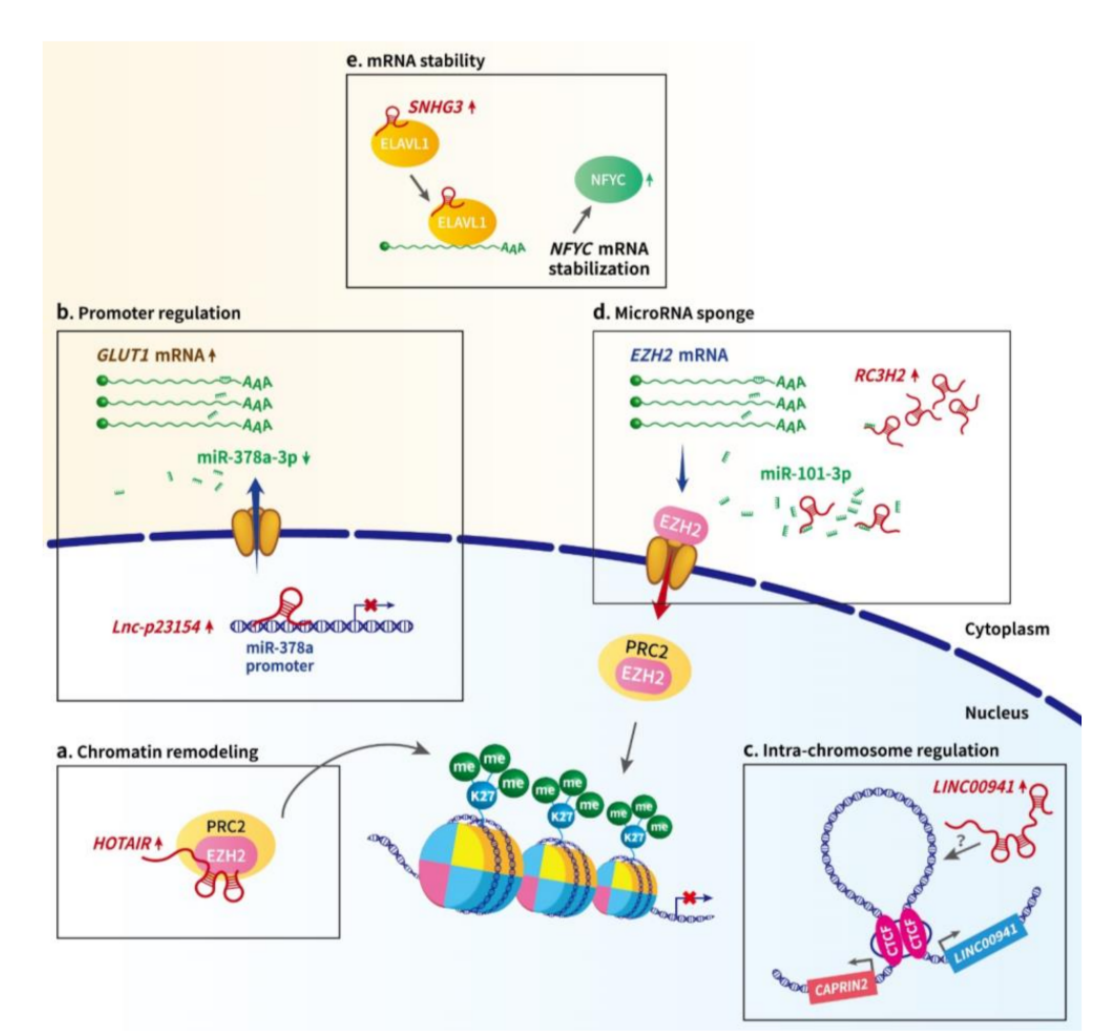
Figure 1. The potential actionmechanisms of lncRNAs in oral cancer. ( a ) Chromatin remodeling. LncRNA HOTAIR has been recognized as a scaffold interacting with chromatin modifying complexes PRC2 and LSD1 to epigenetically regulate gene expression. In OSCC, HOTAIR knockdown decreased the enrichment of EZH2 (the component of PRC2 complex) and H3K27me3 deposition within the E-cadherin promoter, suggesting HOTAIR could modify chromatin accessibility through recruiting chromatin modifying complex at the transcribed genomic locus. ( b ) Promoter regulation. Nuclear lncRNA lnc-p23154 has been demonstrated to suppress miR-378a-3p transcription by interacting with its promoter region, thereby upregulating the expression of the miR-378a-3p targeted gene, GLUT1 , and promoting Glut1-mediated OSCC metastasis. ( c ) Intra-chromosomal interactions. Through dimerization, transcription factor CTCF could mediate chromatin looping between its binding sites and thereby modulate transcription. LncRNA LINC00941 could activate the expression of its nearby gene CAPRIN2 through CTCF-mediated DNA looping of the specific region between the two genes. ( d ) miRNA sponge/ceRNA. LncRNA RC3H2 could function as a miRNA sponge by physically binding miR-101-3p, whose target is EZH2 mRNA. The upregulated EZH2 subsequently suppresses the expression of the downstream gene CDKN2A , facilitating the malignant behavior of OSCC cells. ( e ) mRNA stability. LncRNA-SNHG3 is able to increase NFYC mRNA stability through interacting with RNA-binding protein ELAVL1, also known as HuR, thereby increasing NFYC protein